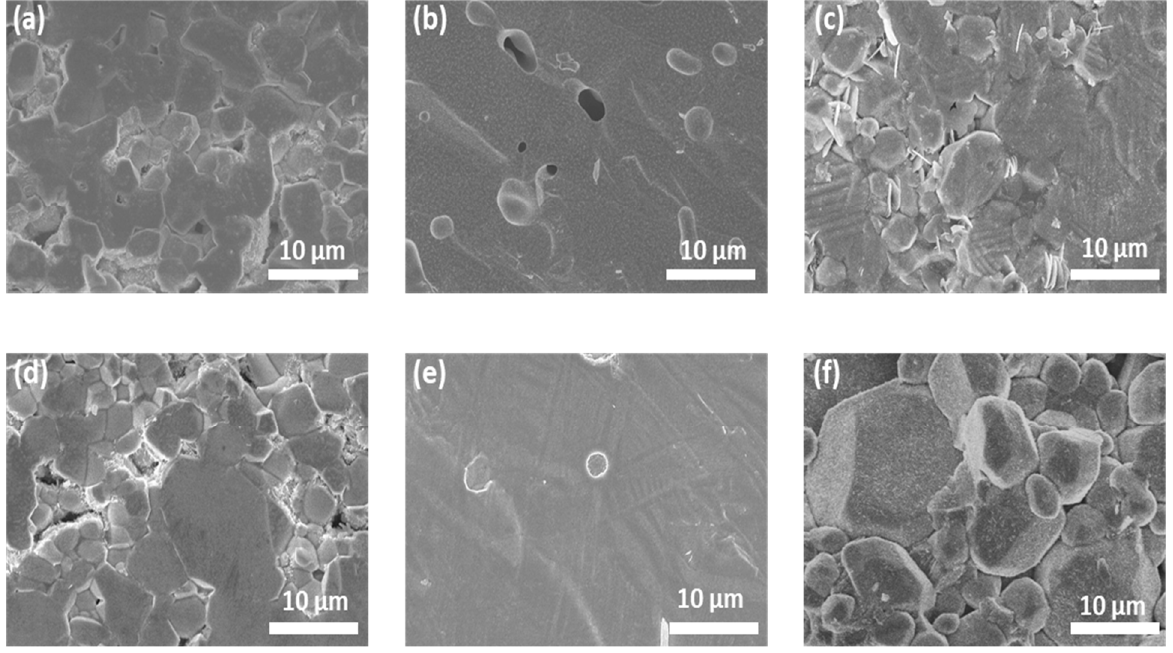
Figure 4. SEM images of the cross-sections of sintered pellets: ( a ) Al_6.9, ( b ) Al_7.7, ( c ) Al_8.4, ( d ) AGT_6.9, ( e ) AGT_7.7, and ( f ) AGT_8.4.